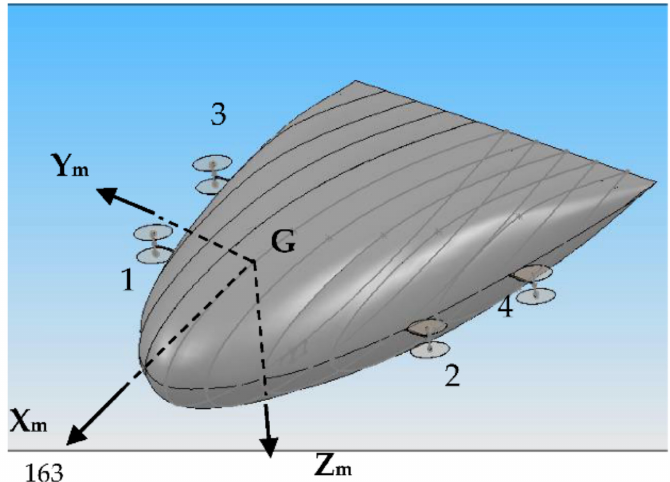
Figure 2. Position of the